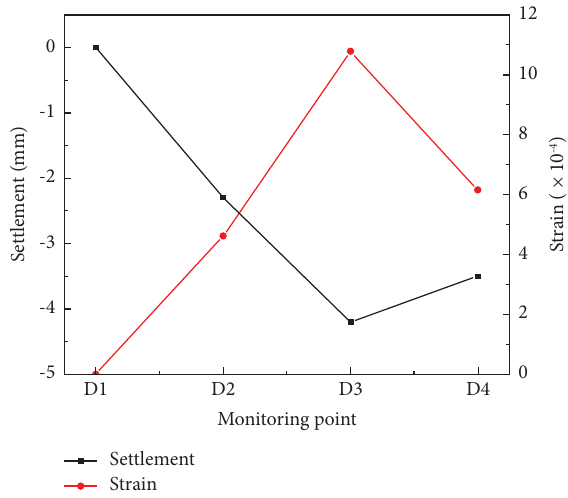
Figure 16: Comparison between calculation results and on-site displacement monitoring